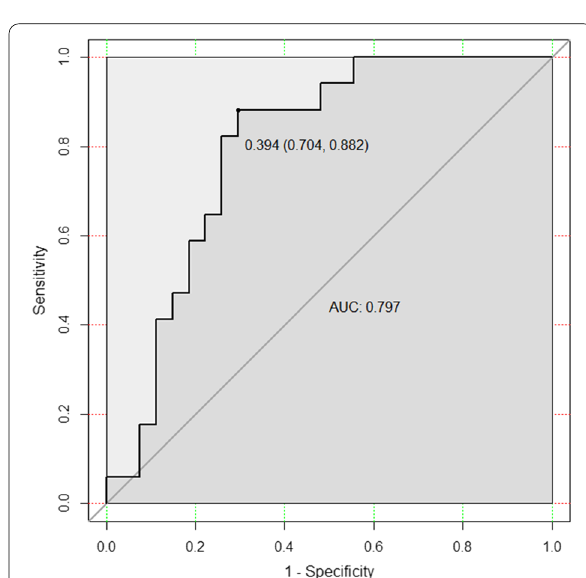
Fig. 2 ROC curve of T-score. ROC, receiver operating characteristic; AUC, area under ROC curve; T-score, the texture score calculated by linear combination of the selected features which were weighted by their respective LASSO coefficients. When the cutoff value is 0.394, the specificity is 0.704 and the sensitivity is